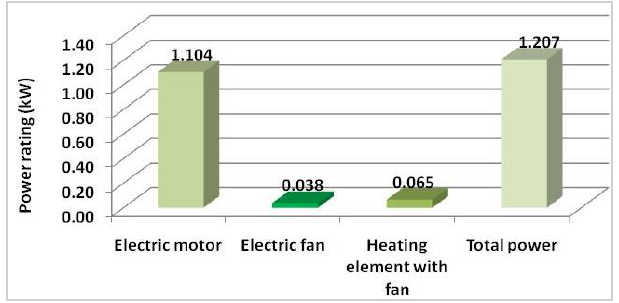
Figure 2. Nominal power rating of the electrical components of the dehulling machine.